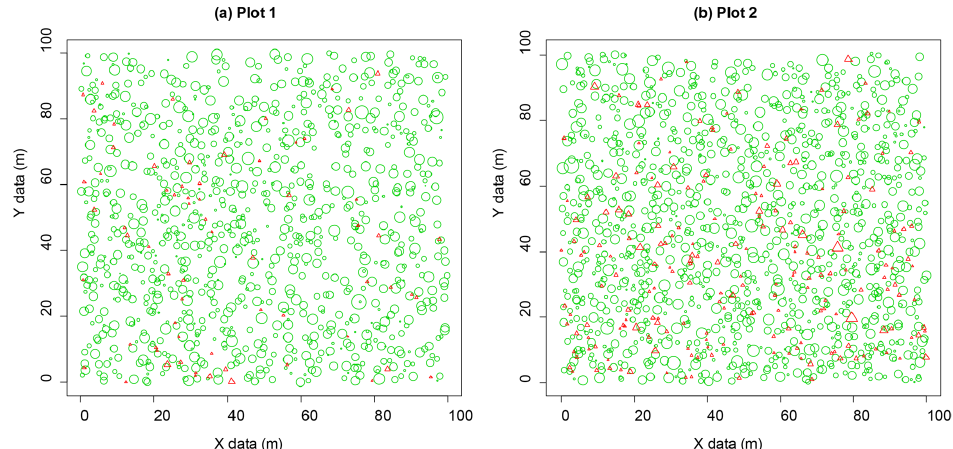
Figure 2. Observed tree point patterns of the two plots: ( a ) plot 1 and ( b ) plot 2. Circles denote live trees and triangles denote standing dead trees. Symbol sizes are proportional to diameter at breast height (DBH). X and Y are two perpendicular coordinate axes of the plots. Table 1. Stand characteristics of the two plots.